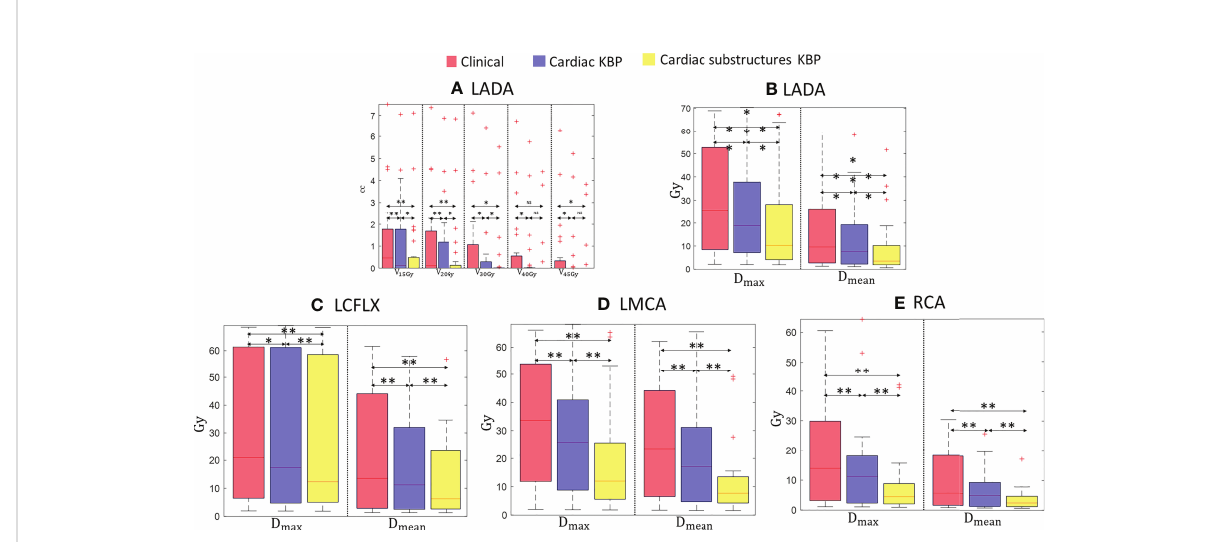
Figure 3 outlines the doses to the chambers of the heart from the three techniques. While there was no signi fi cant differences in maximum dose and V 63 Gy for LA among the three techniques, CS- KBP produced plans with the signi fi cant sparing of LA measured in terms of mean dose (13.34 Gy vs . 16.22 Gy and 17.79 Gy) and V 45 Gy (6.74 cc vs . 7.88 cc and 11.13 cc) in comparison to treatment plans generated by the C-KBP model and manual optimizations (Figures 3A, B). For LV (3.55 Gy vs . 4.72 Gy and 6.52 Gy), RV (2.80 Gy vs . 4.11 Gy and 5.95 Gy) and RA (3.95 Gy vs . 5.59 Gy and 6.55 Gy), CS-KBP produced signi fi cant sparing across all dose volume metrics (Figures 3C-F).